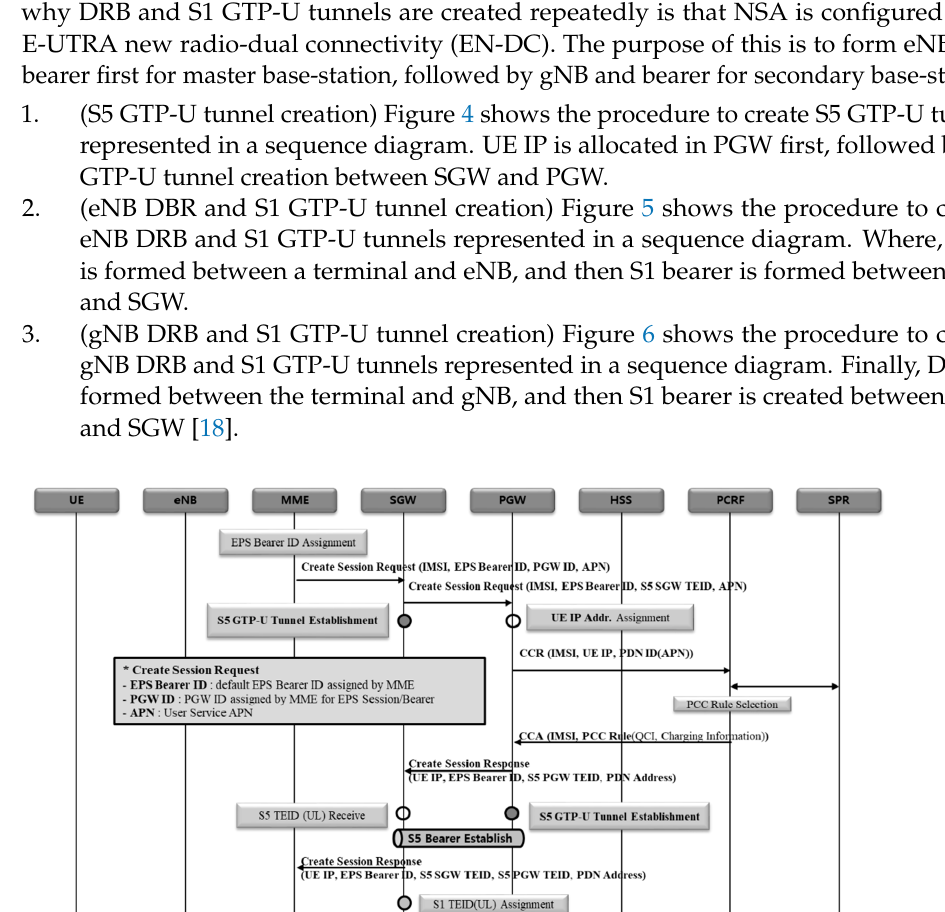
Figure 5. eNB DRB and S1 GTP-U tunnel creation.